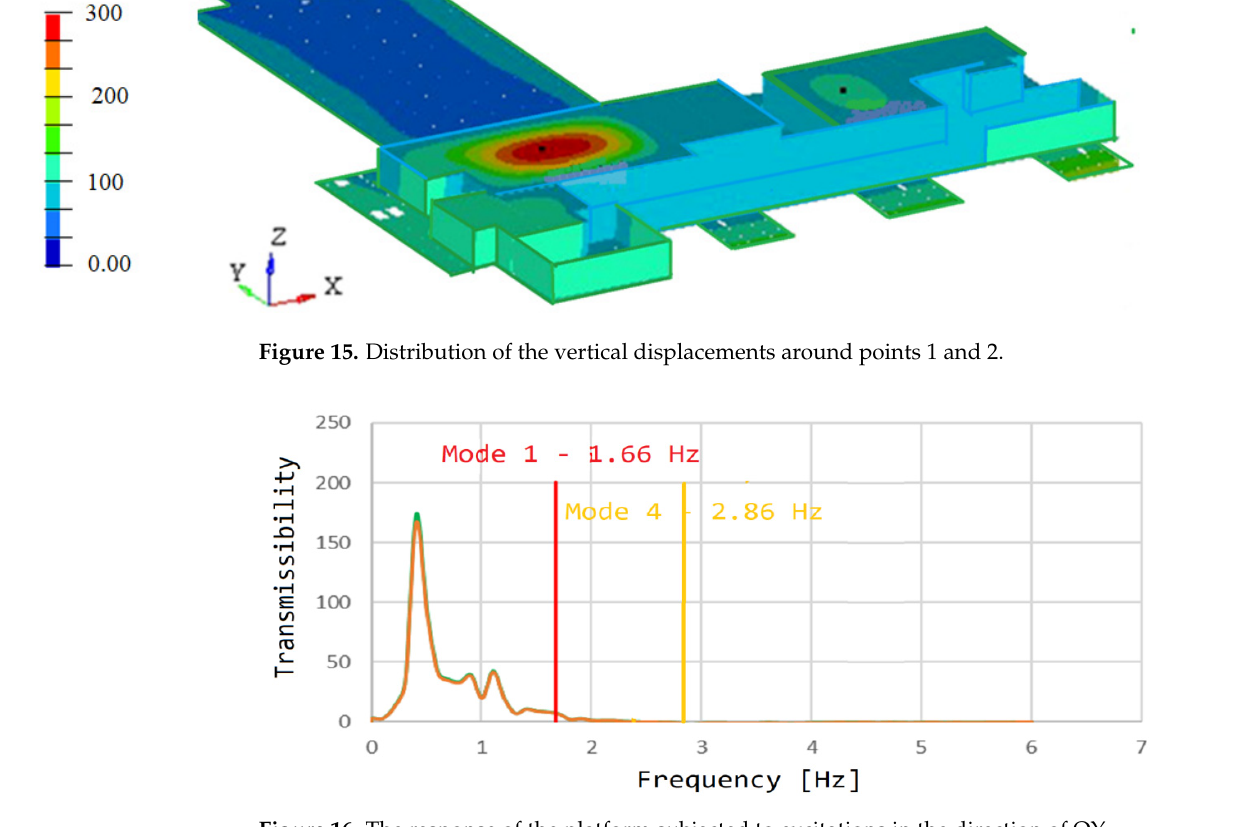
Figure 16. The response of the platform subjected to excitations in the direction of OY.